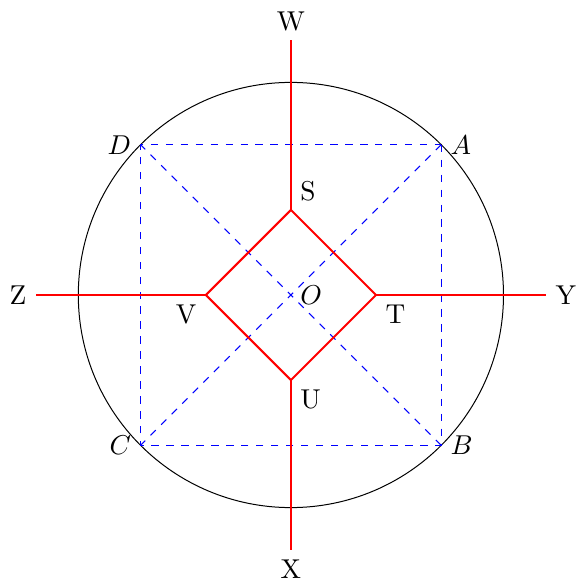
Figure 16. Illustration of the second step in our procedure for constructing a network which approximates a given geometry. In this step, the dual of the graph formed in step one is drawn. The edges of the dual graph are assigned a weight based on the R 2 length of the edges in the direct graph they cut. For example, a weight of Floor( ¯ AB/δ ) is assigned to the edge TY , where δx is a parameter with units of length controlling how closely the graph approximates lengths in the